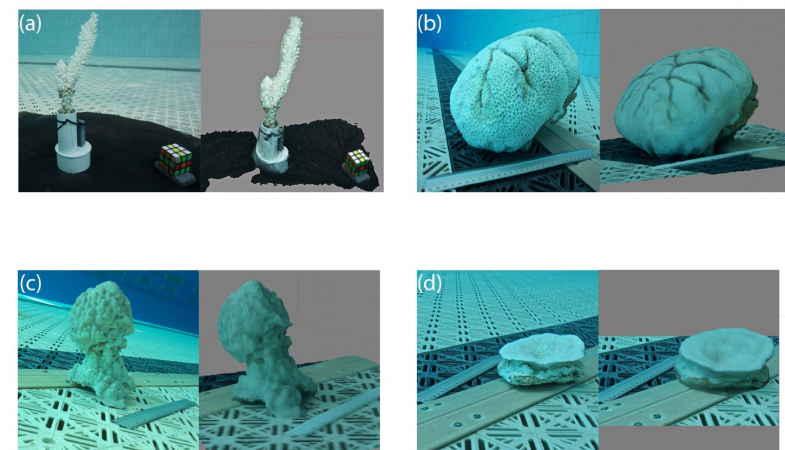
Figure 2. Examples of four of colonies used in this study showing a captured image (left panel) and the resulting fully textured model (right panel); ( a ) Bottlebrush; ( b ) Massive-medium (~30 cm diameter); ( c ) Massive-small (~12 cm diameter) and ( d )